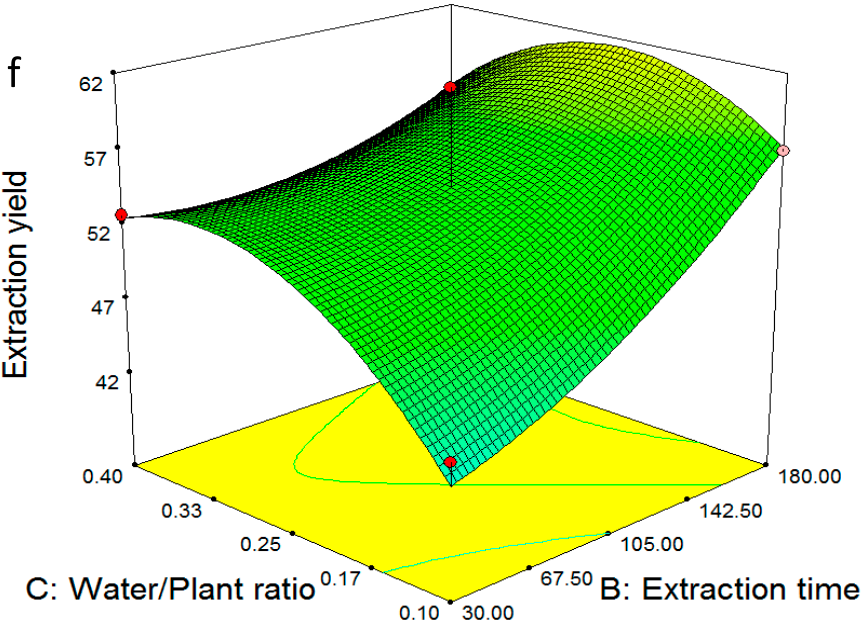
Figure 1. The 3D response surfaces of the extraction yield for the aboveground part ( a – c ) and roots ( d – f ) of O. mutabilis . In ( a , d ), the water/plant ratio was kept constant at 0.25. In ( b , e ), the extraction time was kept constant at 105 min. In ( c , f ), the temperature was kept constant at 150 °C.